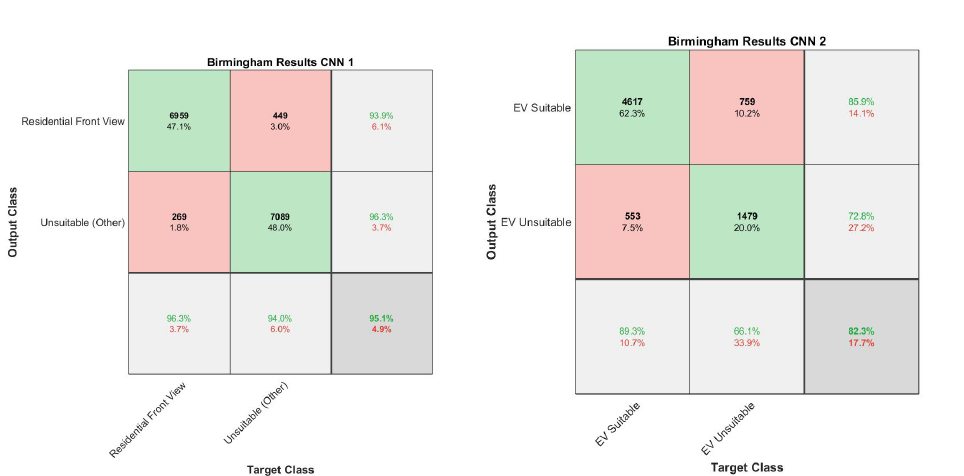
Figure 10. The resultant confusion matrices for CNN 1 and CNN 2 on the Birmingham testing